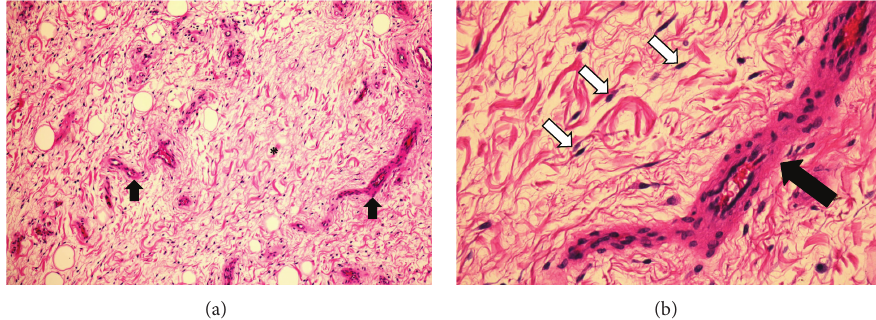
Figure 4: (a) Low-power (10x) H&E slide showing widely scattered bland spindle cells within a myxoid background (asterisk) with accompanying vascular structures (arrows). (b) High-power (40x) H&E slide showing bland spindle cells (white arrows) scattered within a myxoid background and nearby vascular structures (black